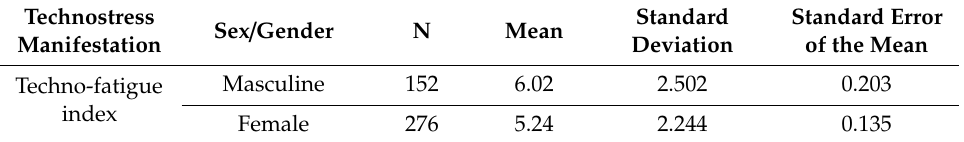
Table 5. Techno-fatigue statistics by gender.